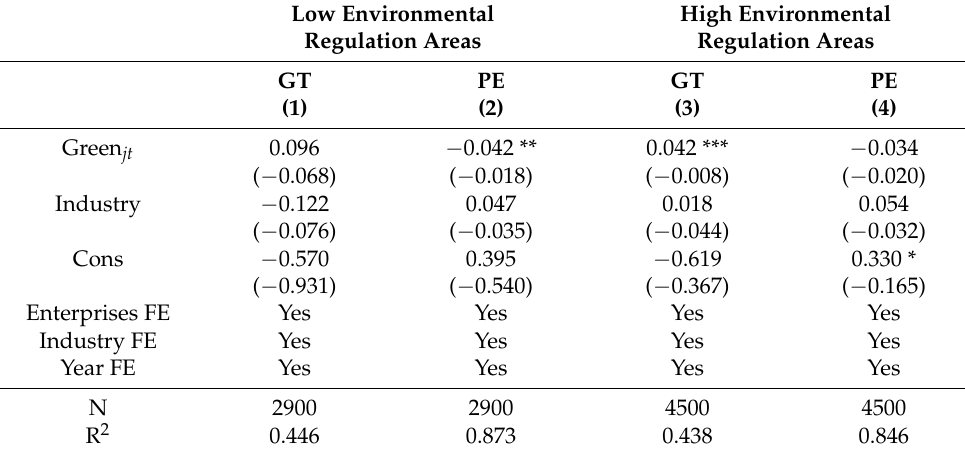
Table 8. Heterogeneity analysis